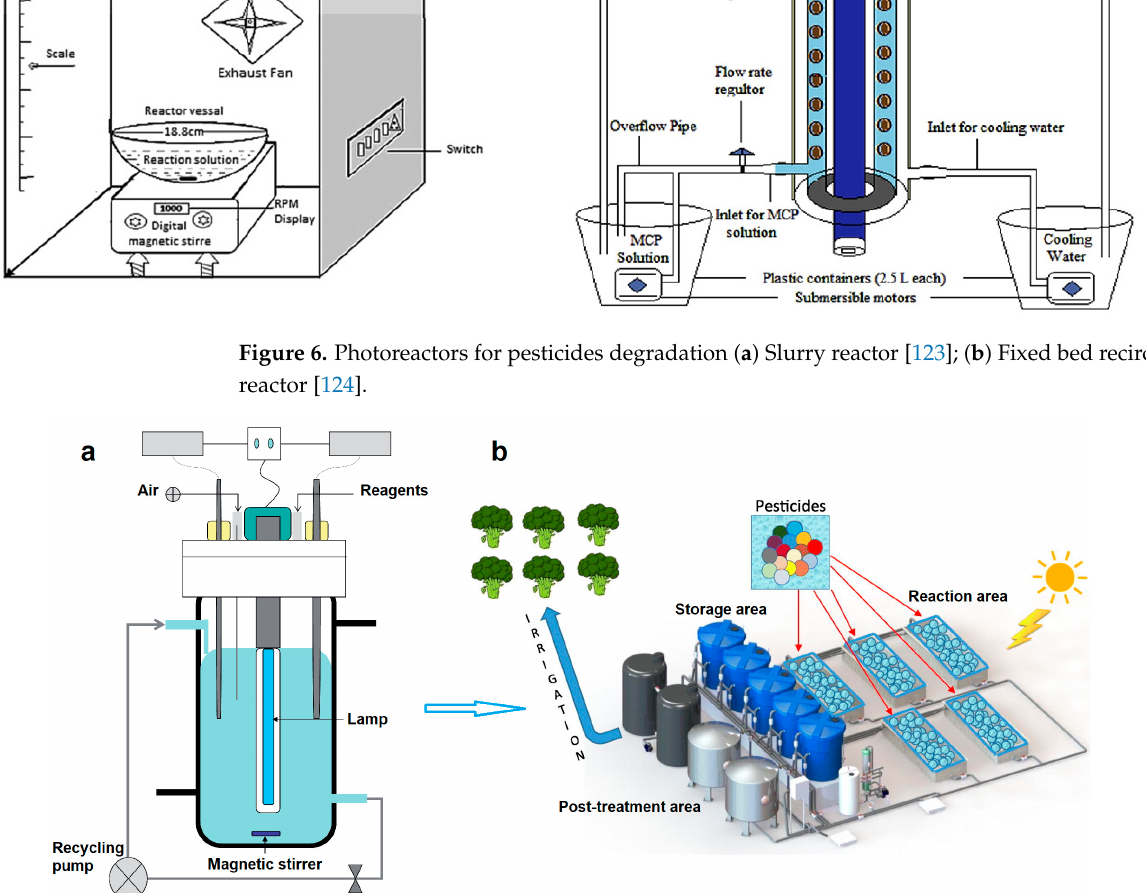
Figure 6. Photoreactors for pesticides degradation ( a ) Slurry reactor [123]; ( b ) Fixed bed recircula- tion reactor [124].